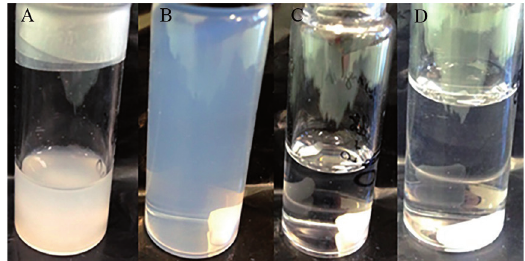
Figure 1: A and C: Solution of copolymer and lavender oil in organic solvent (acetone); B and D: nanoparticle suspension with encapsulated lavender